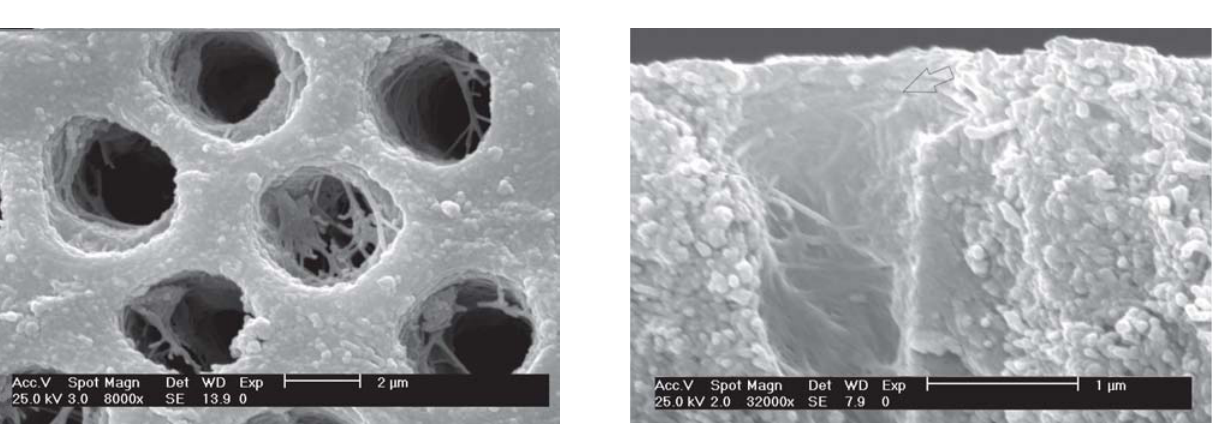
FIGURE 3 - SEM micrograph of group 1 (no treatment) - Lateral view of the dentinal tubules. Observe the tubules filled in with debris (smear plugs) (arrows) produced by 600-grit silicon paper grinding (x8,000)